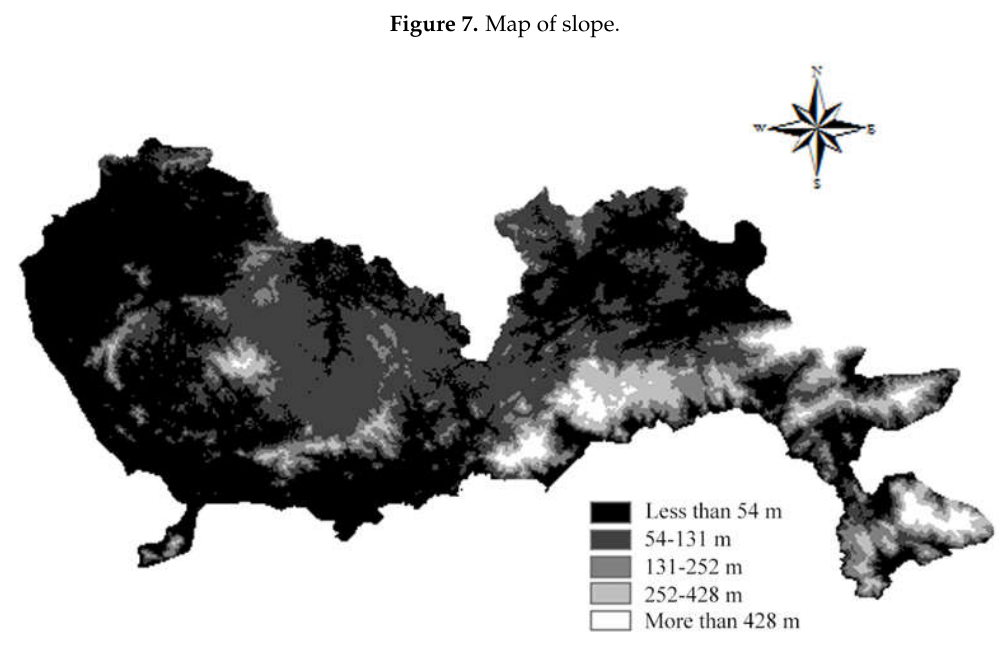
Figure 8. Map of Figure 8. Map of altitude. Figure 8. Map of altitude.